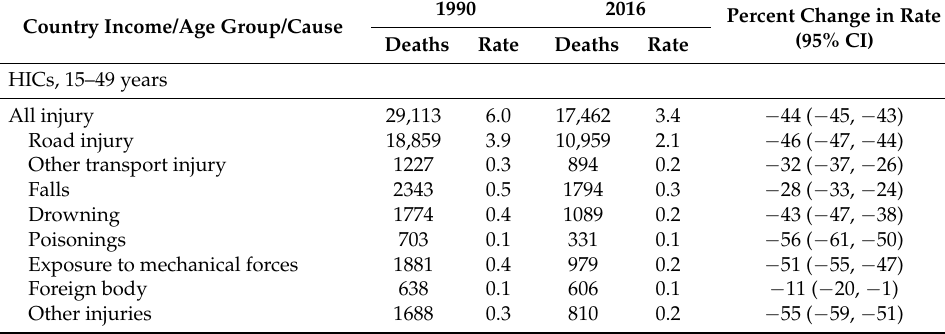
Table 1. Age-specific unintentional occupational injury mortality (/100,000 persons) by country income, age group, and cause among 15 to 69 years between 1990 and